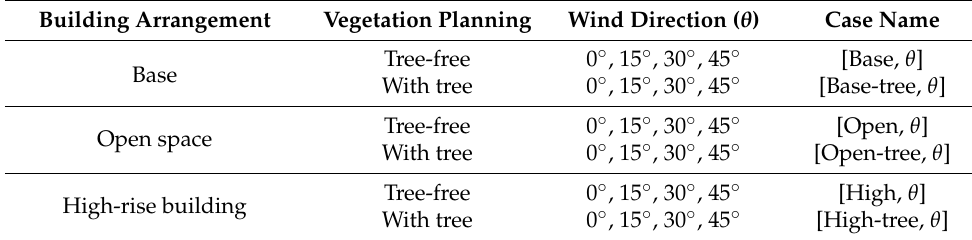
Table 1. Scenarios tested in this work. Different urban designing and wind direction are considered for the